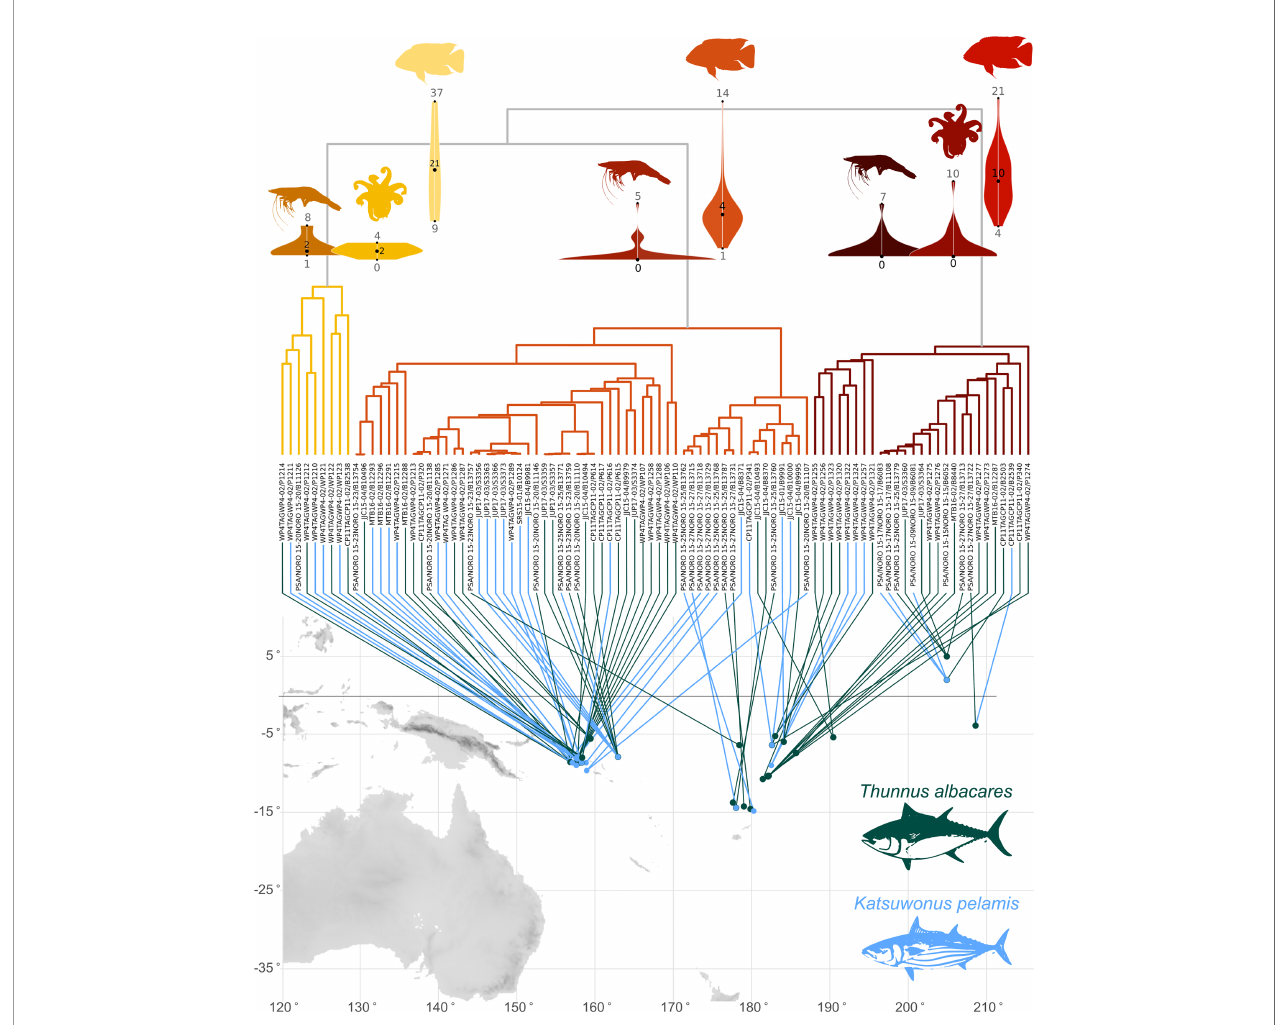
FIGURE 2 | Hierarchical clustering of Katsuwonus pelamis (light blue) and Thunnus albacares (dark green) prey captured across the Paci fi c during 2015-2017. Three mayor clusters are shown in yellow (Cluster 1), orange (Cluster 2) and red (Cluster 3). Violin plots above each cluster represent the mean number of Actinopterygii, Crustacea and Cephalopoda species present in the stomachs of K. pelamis and T. albacares within the